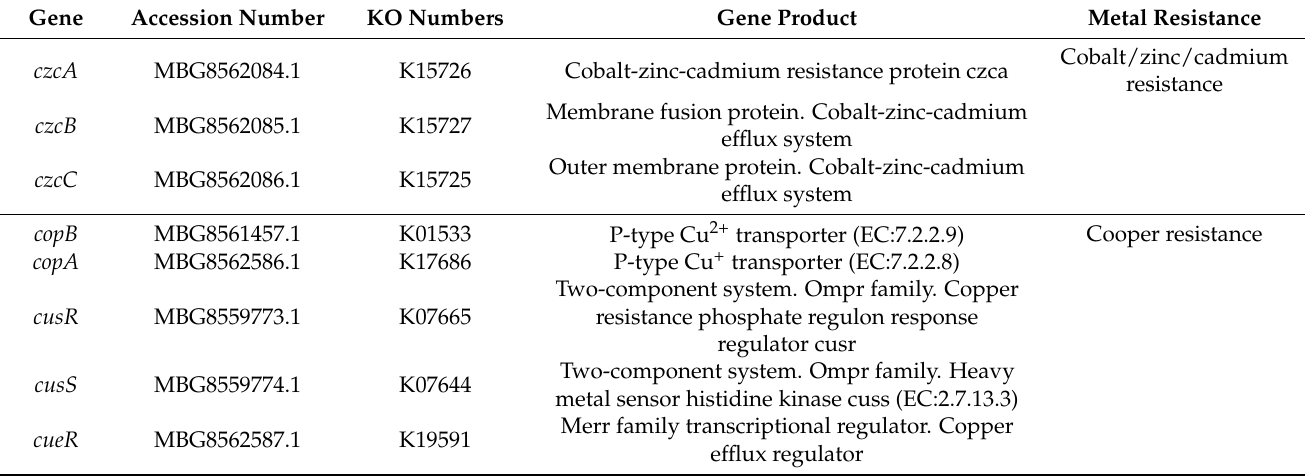
Table 5. Genes potentially involved in metal resistance in the ZCR6